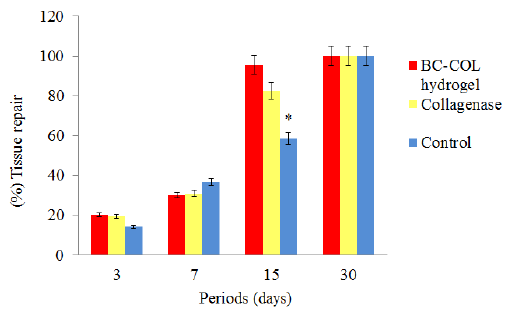
Figure 5. Values measured for the tissue repair of wounds of the GI, GII and GIII groups for experimental periods of 3, 7, 15 and 30 days. Values are expressed as mean ± standard error; * p<0.05. The one-way ANOVA followed by the post-hoc t test (LSD) were